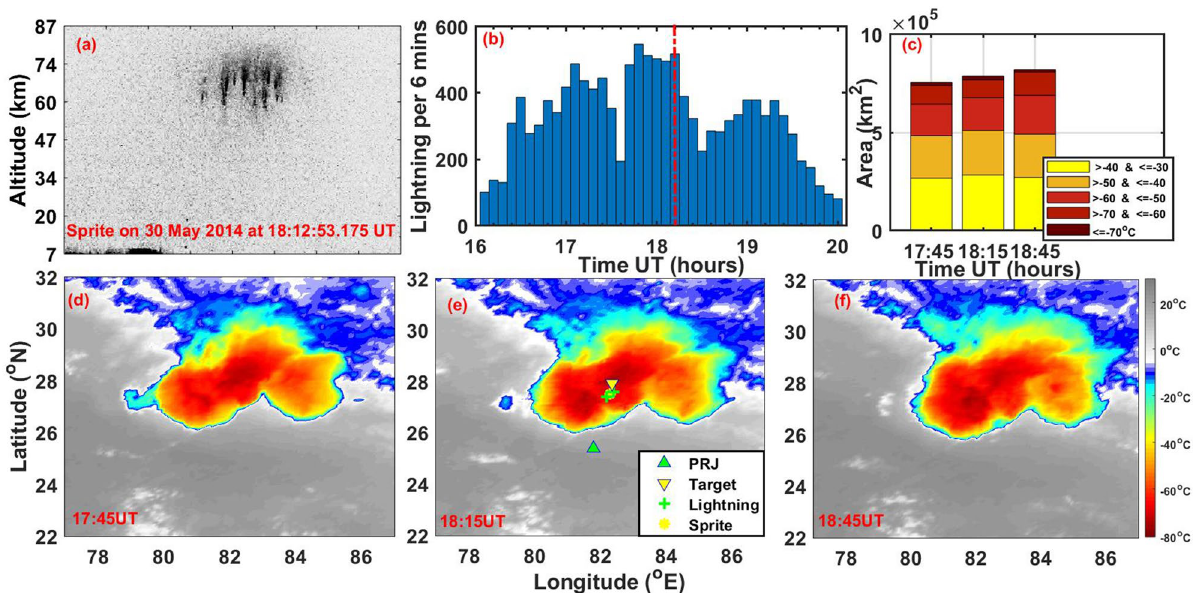
Figure 2. ( a ) Sprite event recorded on 30 May 2014 at 18:12:53.175 UT. The altitude scale corresponds to a distance of camera-sprite event of 260 km. ( b ) The lightning occurrence rate per 6 min for + CG and − CG lightning during (16–20 UT) was obtained from the GLD360 lightning location network. ( c ) The cloud top area variation for different temperature ranges at 17:45, 18:15 and 18:45 UT. ( d – f ) presents cloud top temperature at 17:45, 18:15 and 18:45 UT obtained from Kalpana1 meteorological satellite IR brightness temperature data. We aimed the center of the camera field-of-view at a target TLE location indicated by the downward yellow triangle. The two green overlapping crosses indicate the locations of the lightning used to estimate the sprite location which is given by a yellow